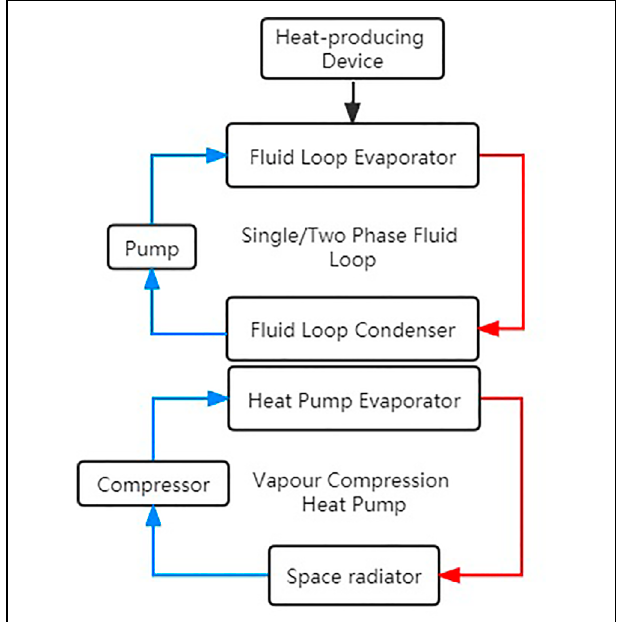
FIGURE 3 | Schematic diagram of heat pump